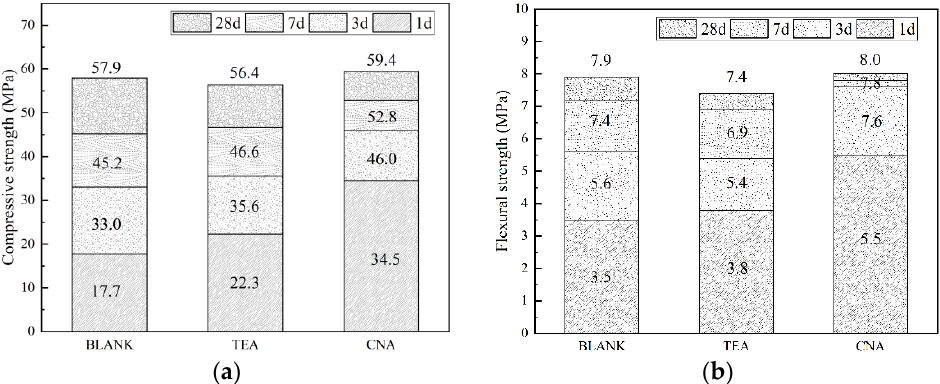
Figure 8. 28 d BSE image of cement mixture with nothing ( a ), CNA ( b ) and TEA ( c ); the gray histogram of cement mixture with nothing ( d ), CNA ( e ) and TEA ( f ).